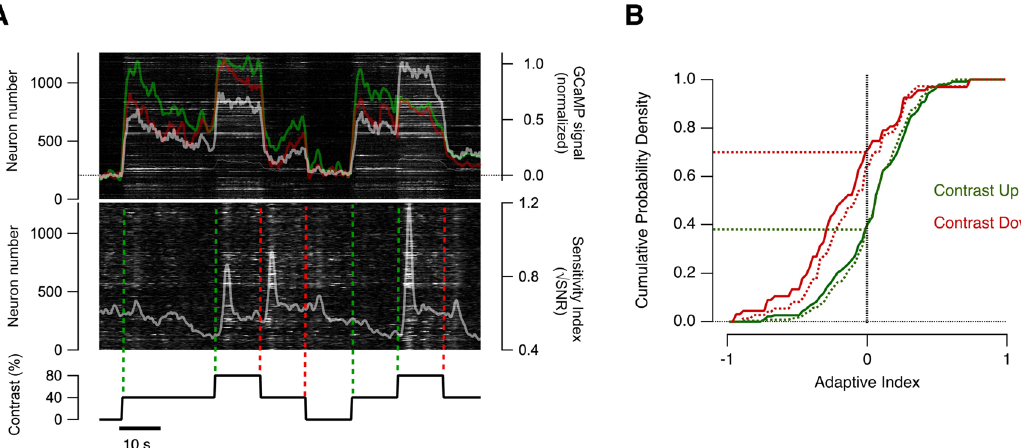
Fig. 2 The majority of neurons detecting a decrease in contrast displayed sensitizing adaptation. A Raster plots showing the responses (top) and sensitivity index d ′ (bottom) of 1261 PCs during presentation of a stimulus of changing contrast. The average is shown by the superimposed white traces. The green dashed lines indicate the contrast increases and the red line the contrast decreases. Setting a detection threshold of d ′ > 1.41, 231 PCs detected either increase (18%, average response in green) while 67 detected the decrease (5%, average response in red). B The distribution of AIs of PCs detecting a contrast increase and decrease expressed as a cumulative density. Solid lines show the distribution for all transitions. Of PCs detecting the increase, 61% had an AI > 0, while 70% detecting the decrease had an AI < 0. The two distributions were different at p = 0.1 (Kolmogorov – Smirnov test). Dashed lines show this relation only for transitions from 40% contrast. In both cases, the AI was calculated from the transition from 40 to 80% contrast. Source data are provided as a Source Data fi